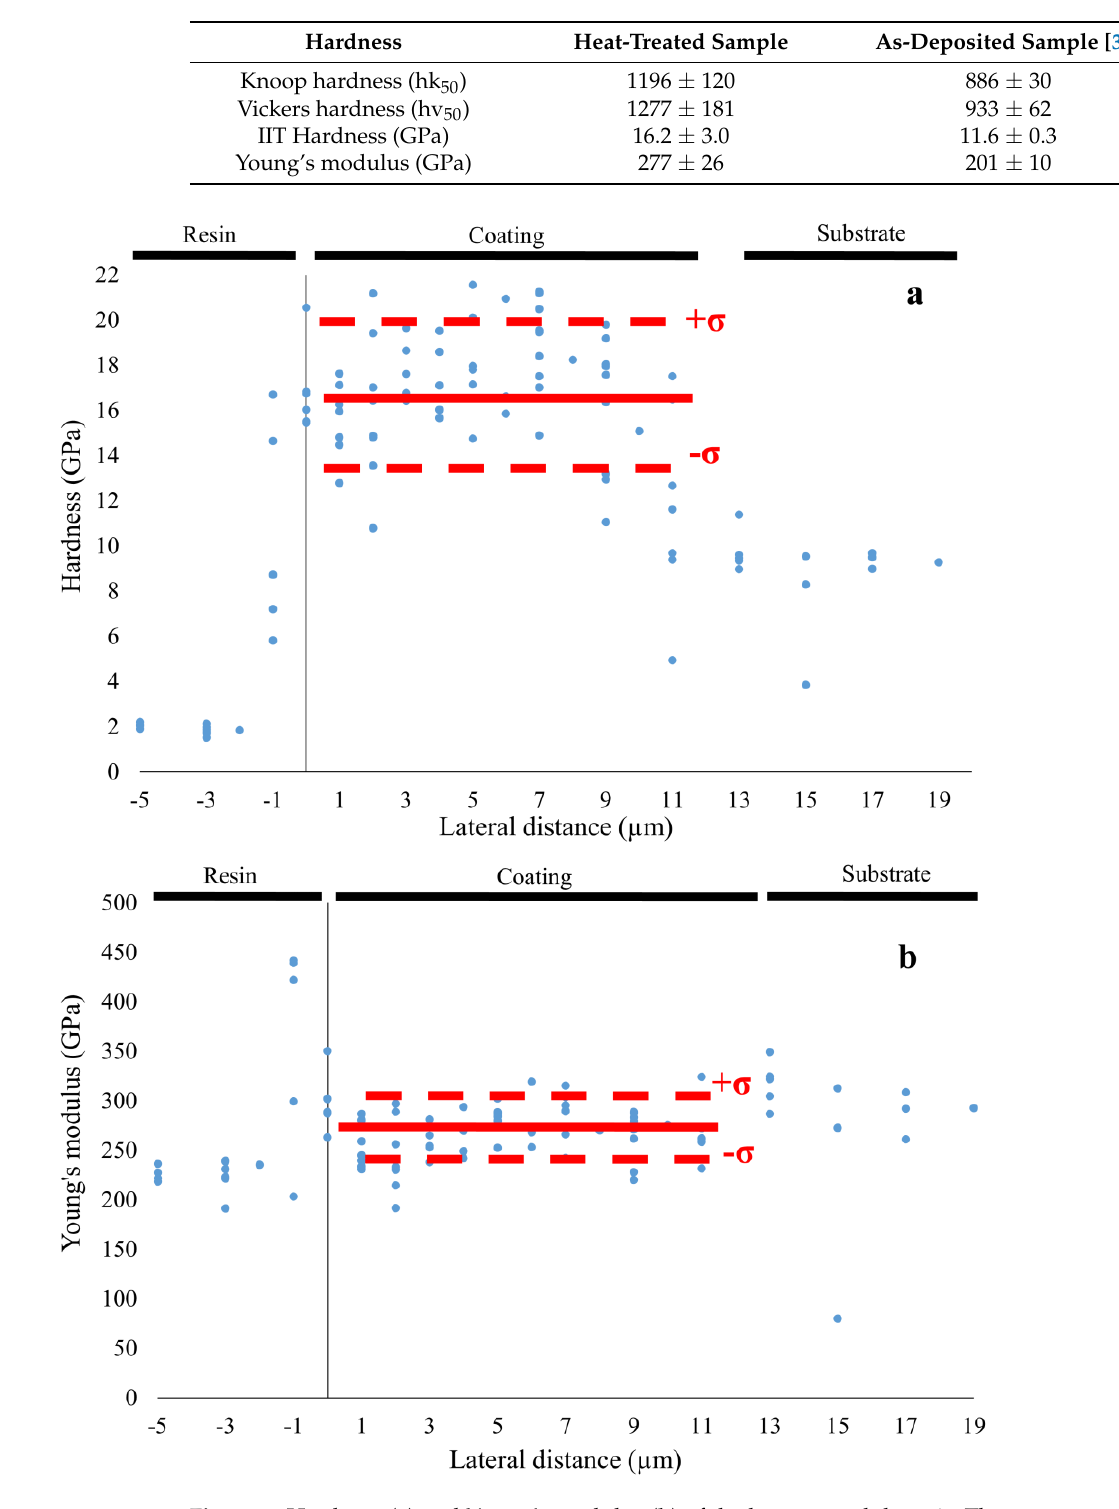
Table 4. Comparison of the mechanical properties of samples in the as-deposited and optimized heat-treated conditions.